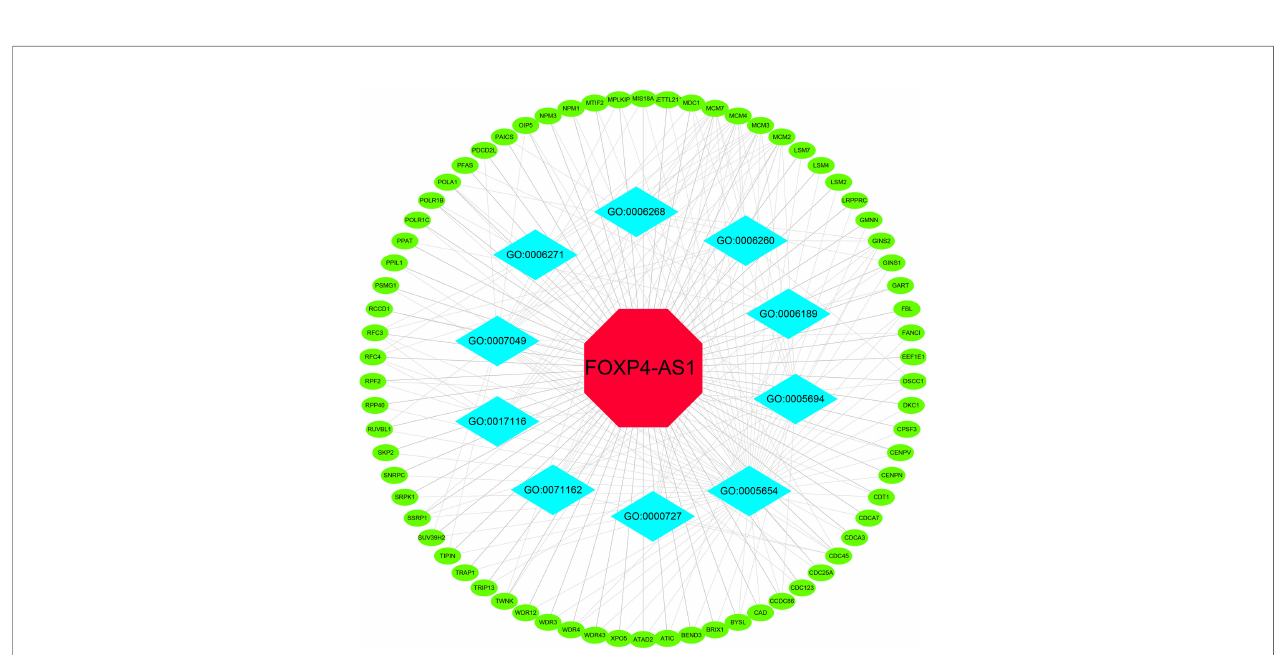
FIGURE 10 | Differentially expressed gene interaction network analysis. Green nodes represent target genes and sky blue nodes represent the related pathway. GO:0005654 (nucleoplasm); GO:0005694 (chromosome); GO:0071162 (CMG complex); GO:0007049 (cell cycle); GO:0006268 (DNA unwinding); GO:0006271 (DNA strand elongation); GO:0017116 (ATP-dependent DNA helicase activity); GO:0000727 (double-strand break repair); GO:0006189 ( ‘ de novo ’ IMP biosynthetic process); GO:0006260 (DNA